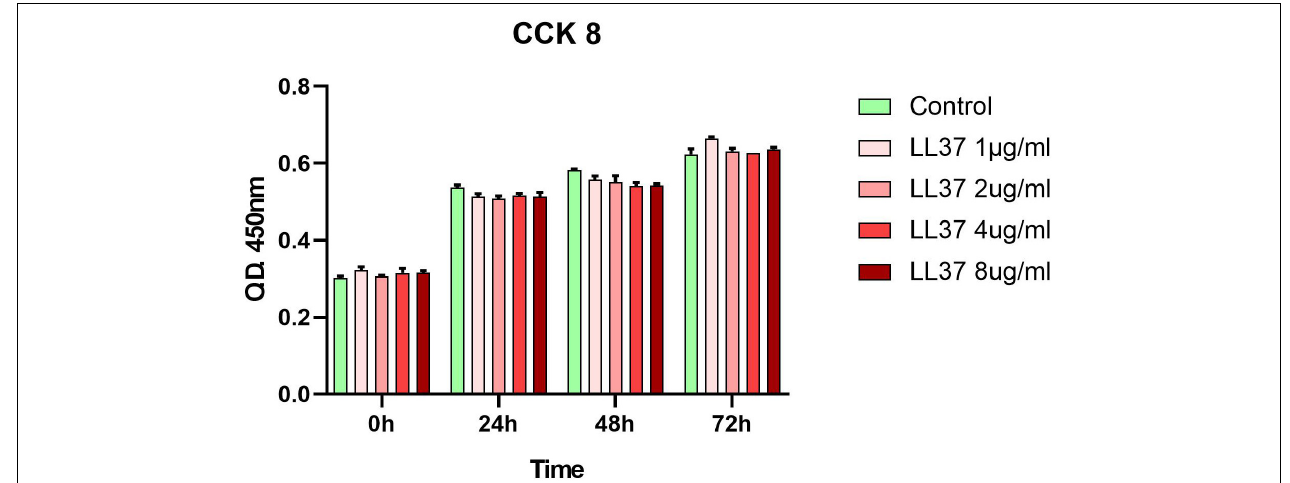
FIGURE 1 | Effects of LL37 on the proliferation of human ADSCs. Cellular viability was evaluated using a cell counting kit-8 (CCK-8) assay and analyzed with the OD450 nm value ( n = 3, unpaired t